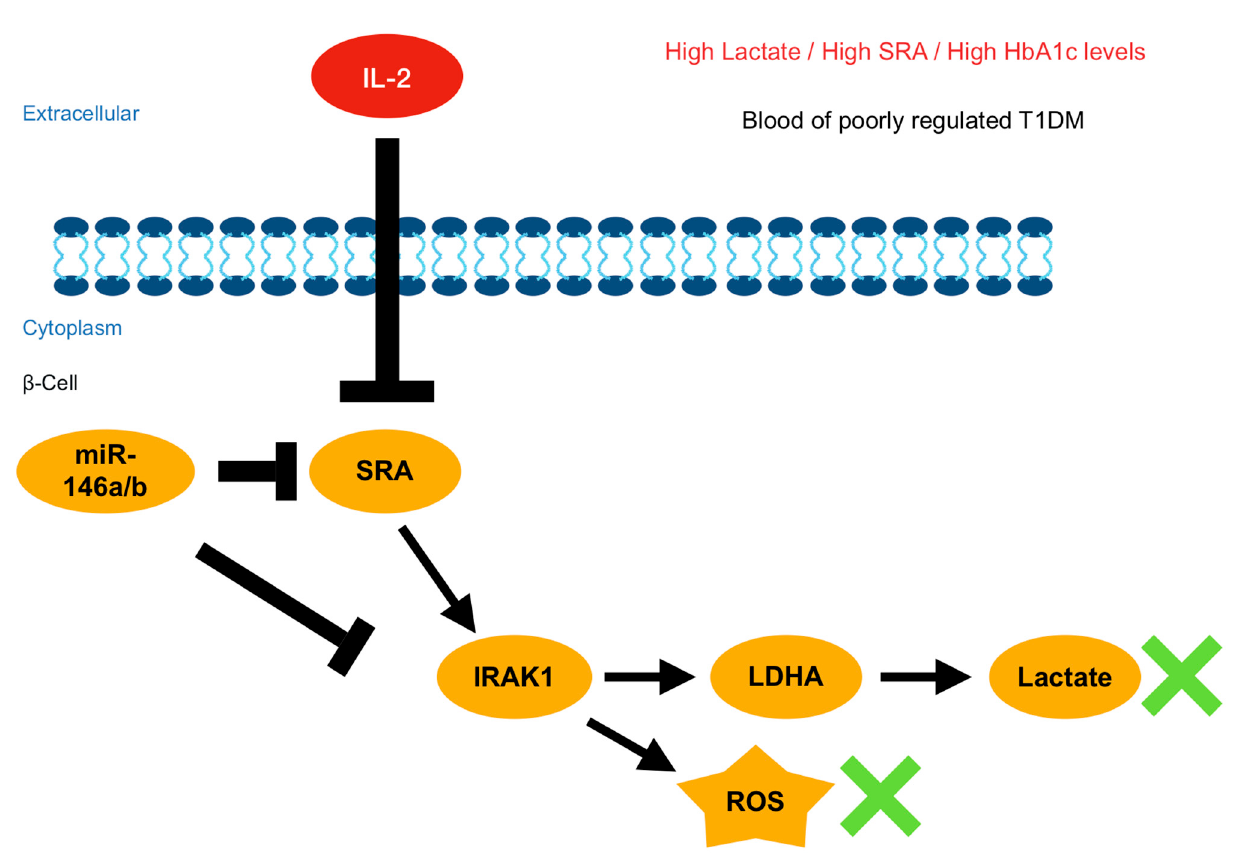
Figure 7. Schematic diagram summarizes aberrant lncRNA SRA-mediated networks in β -cells of T1D. The panel indicates that the aberrant expression of IRAK1 and LDHA by lncRNA SRA induction through competing miR-146b and driving metabolic reprogramming and IL-2 treatment represses the lncRNA SRA-mediated IRAK1/LDHA signaling pathway. (green x means products inhibition)